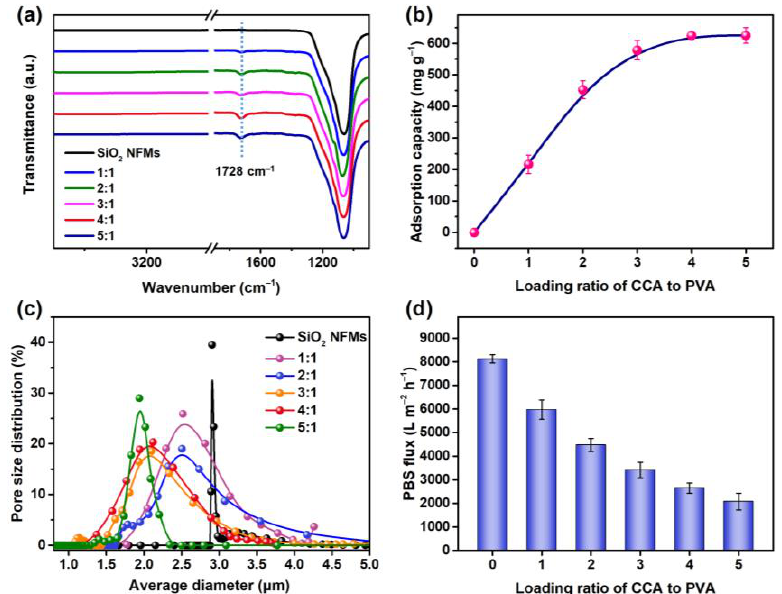
Figure 3. ( a ) FT-IR spectra, ( b ) protein adsorption capacities, ( c ) pore size distribution, and ( d ) PBS flux of the SiO 2 NFMs and the composite NHMs prepared from different loading ratios of CCA to PVA.